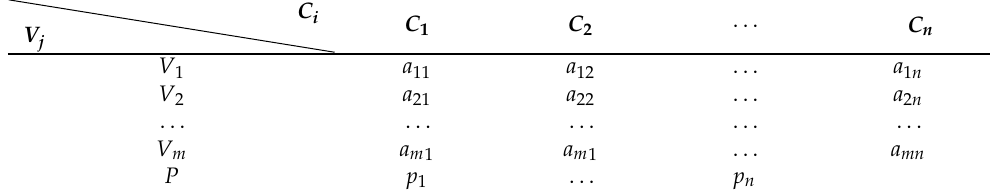
Table 1. Decision or consequences